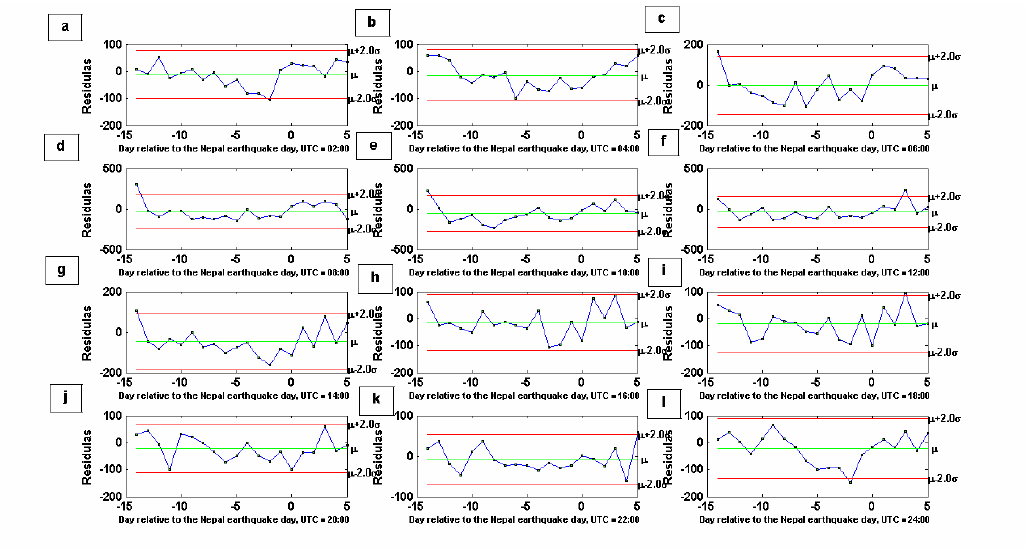
Fig. 7. a) through l) Variations of the differences between the observed and the predicted values of TEC obtained from LSSVM method on days selected as testing set at different universal times. The red horizontal lines indicate the upper and lower bounds ( σµ ×± 2 ). The green horizontal line indicates the mean value ( µ ). The X-axis represents the day relative to the Nepal earthquake